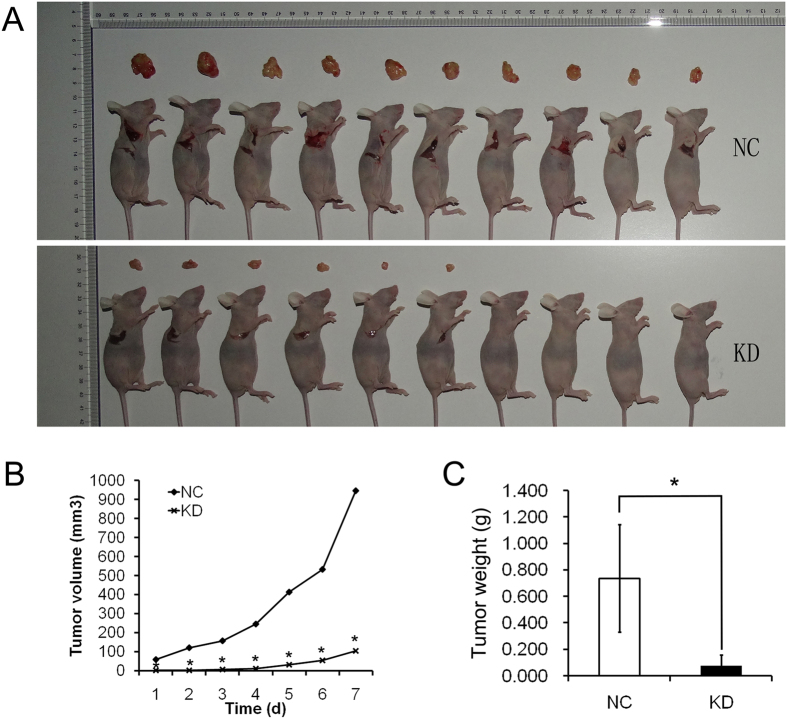
Effects of DDX51 knockdown on xenograft tumorigenicity in vivo in nude mice.H1299/NC and H1299/KD cells were injected into the flanks of nude mice. Tumour growth (A) and tumour volume (B) were measured on the indicated days. Tumour weights were measured 4 weeks after injection (C). NC, negative control; KD, DDX51 knockdown. *P < 0.05.